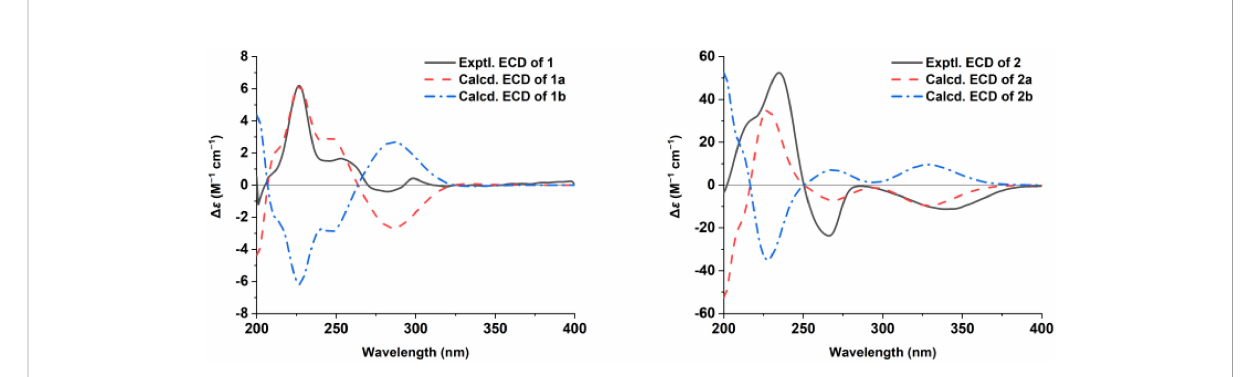
FIGURE 3 The calculated and experimental electronic circular dichroism (ECD) spectra of 1 and 2 .